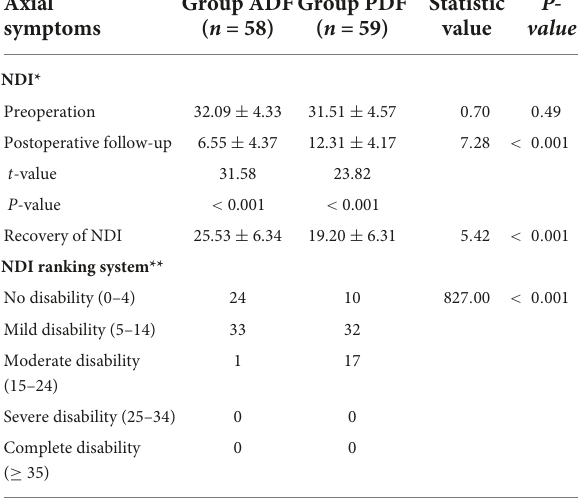
TABLE 4 PreOP and PostOP follow-up Axial symptom severity [neck disability index (NDI) scores] in each